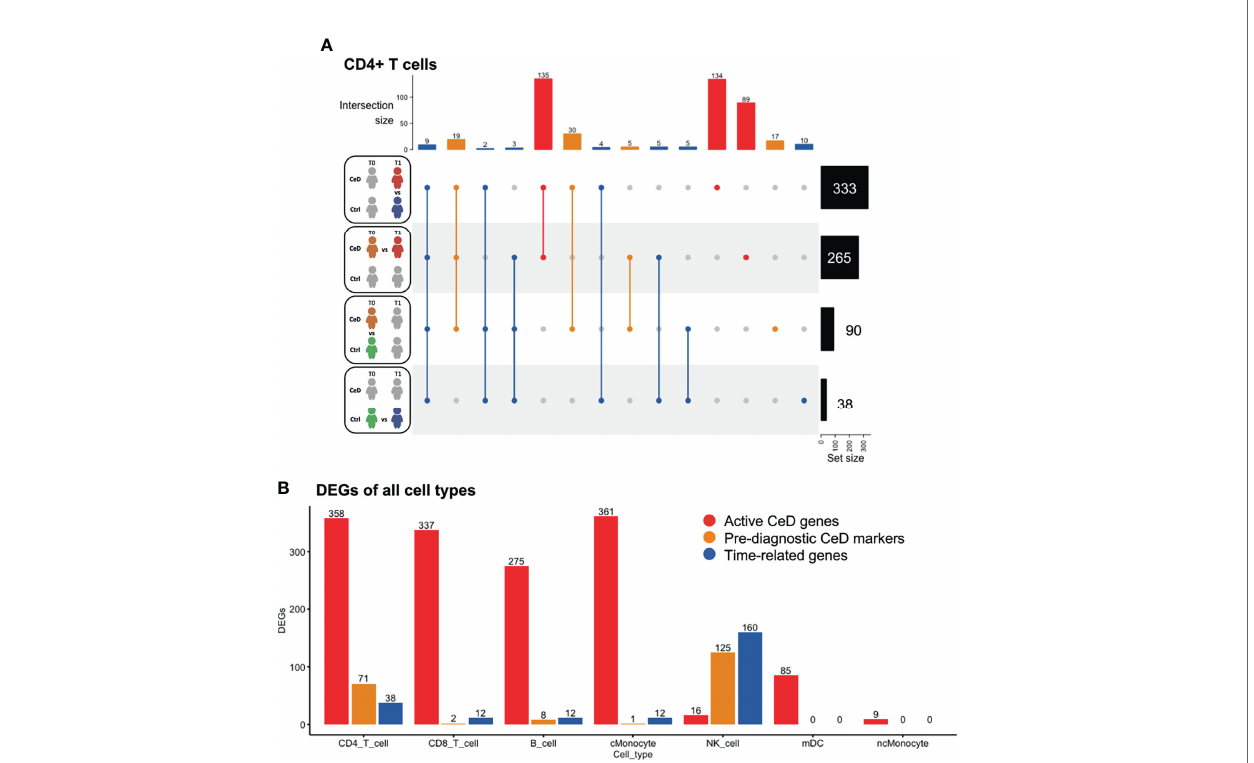
FIGURE 2 | Differentially expressed genes classi fi ed in three groups. (A) Intersection of DEGs between different comparisons in CD4 T cells. The total number of DEGs per comparison is displayed on the right. Four comparisons were performed, as represented in the left part of the fi gure: CeD cases T1 vs. controls T1, CeD cases T0 vs. T1, CeD cases T0 vs. controls T0 and controls T0 vs. T1. The number of intersected DEG is shown at the top of the fi gure, in order of priority: time- related – all genes that showed overlap with comparison of controls T0 vs. T1, pre-diagnostic CeD markers – DEGs from the comparison of CeD T0 vs. controls T0, active CeD – DEGs from the comparison of CeD T1 vs. controls T1 and unique DEG when comparing the CeD T0 vs. T1. (B) An overview of the number of DEGs in different comparisons and cell types. On the y-axis, the number of DEGs (FDR < 0.05, absolute log2FC > 0.25) is displayed for active CeD (red), pre-diagnosis (yellow) and aging or time-related (blue). On the x-axis, the cell types are